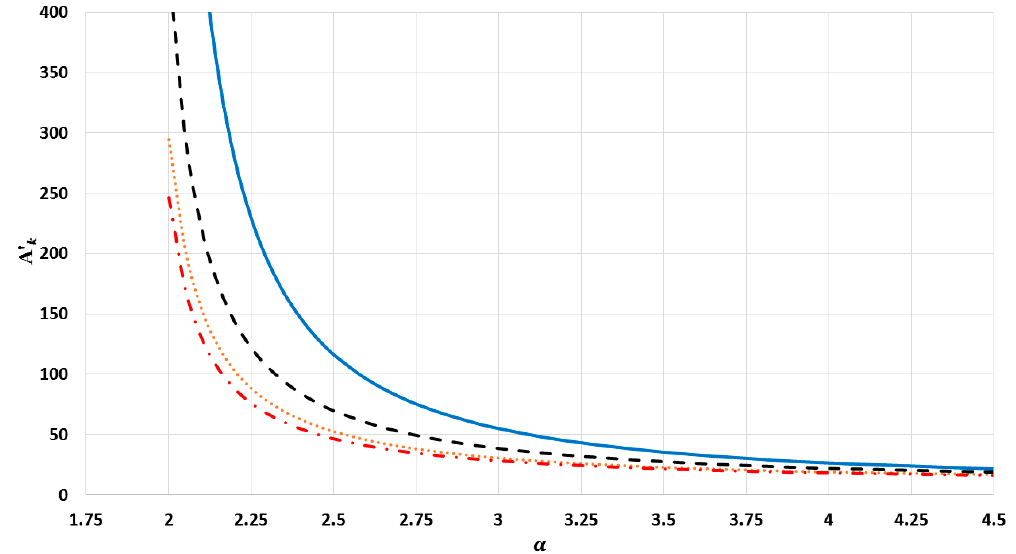
Figure 2. The variation of (cid:1827)′ (cid:3038) ((cid:1870) (cid:2868)∗ ) for a face-centered cubic metal with the (cid:2009) parameter for (cid:1865) = 2 , where the blue solid line represents (cid:1827)′ (cid:2872) ((cid:1870) (cid:2868)∗ ) , the black dashed line represents (cid:1827)′ (cid:2871) ((cid:1870) (cid:2868)∗ ) , the red dashed- dotted line represents (cid:1827)′ (cid:2870) ((cid:1870) (cid:2868)∗ ) , and the orange dotted line represents (cid:1827)′ (cid:2869) ((cid:1870) (cid:2868)∗ ) .